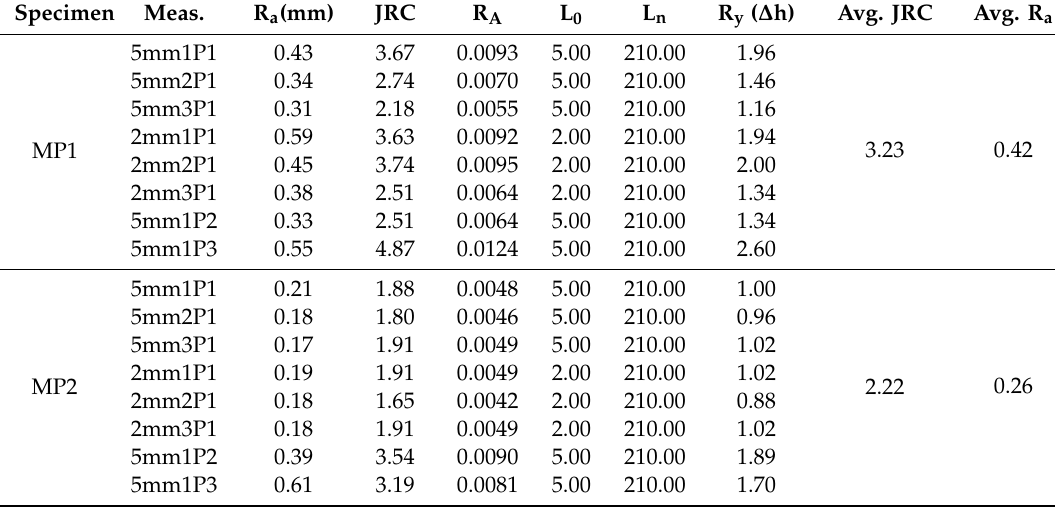
Table A2. Results from roughness tests. Average curves